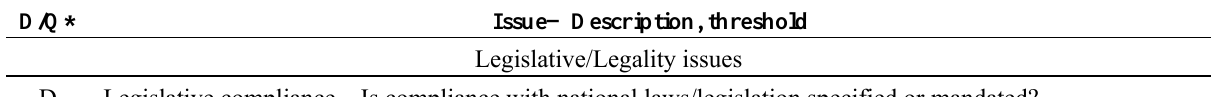
Table 1. Key indicators of sustainable forest